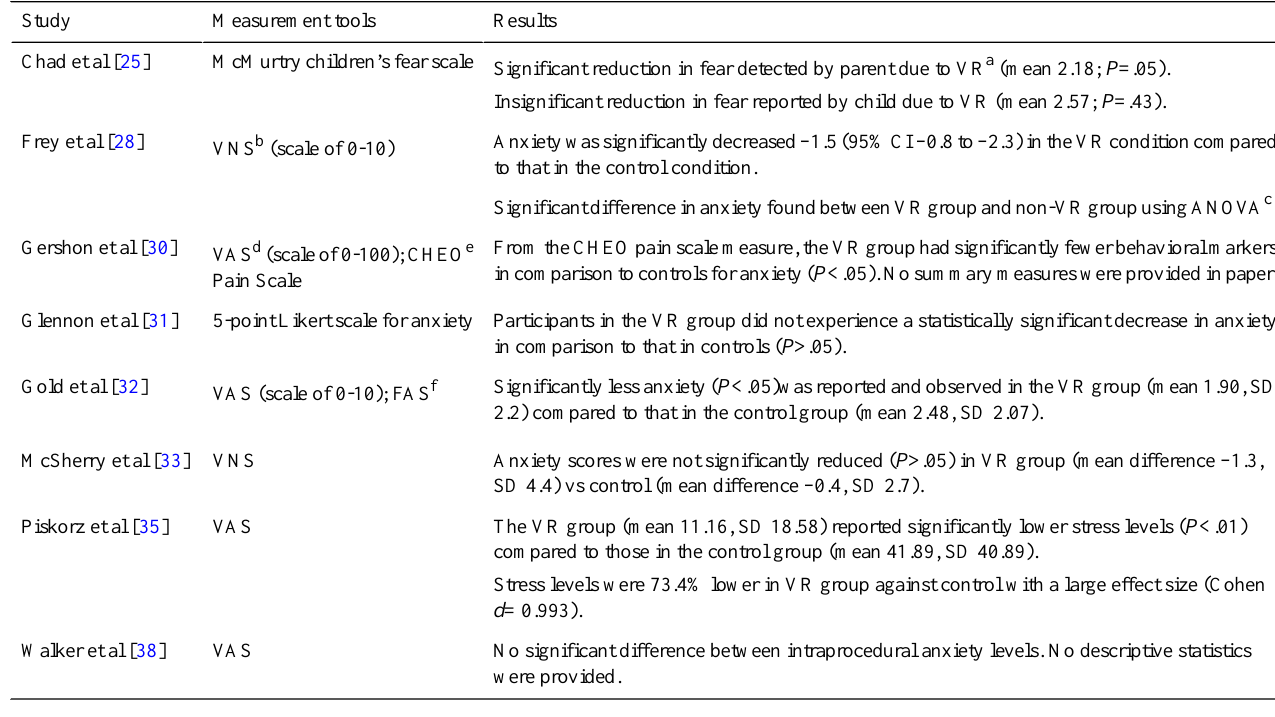
Table 3. Summary measures of studies in review which measured forms of anxiety. ResultsMeasurement